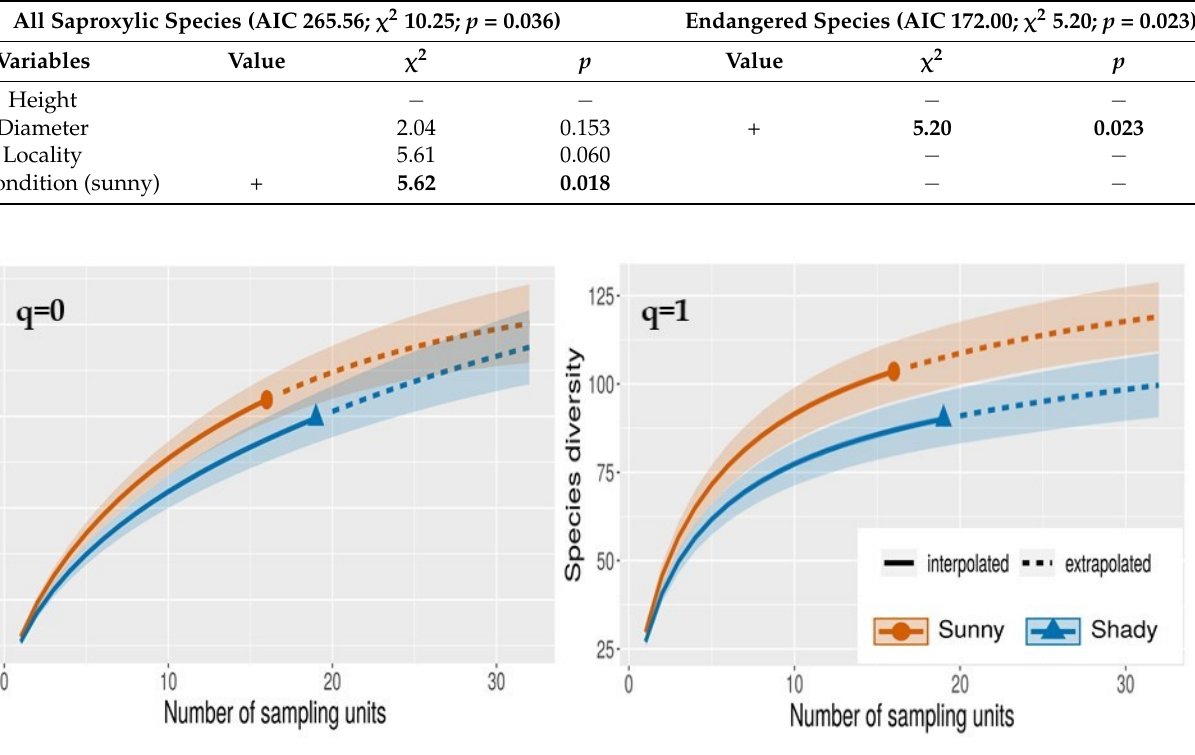
Figure 6. Sample-size-based rarefaction and extrapolation sampling curves within light condition sites showing Hill numbers q = 0 (species richness) and q = 1 (exponential of Shannon entropy index). Color-shaded areas are 95% confidence intervals. Solid symbols represent the total number of study samples.